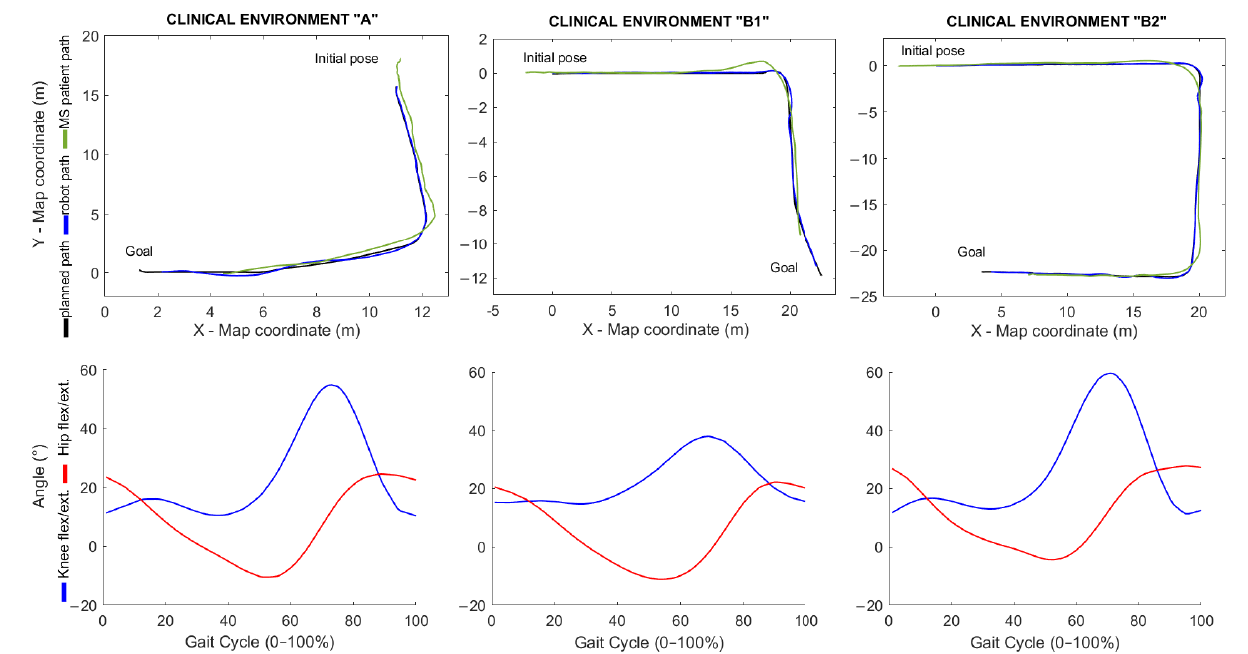
Figure 11. Walking experiments with MS patients in clinical environments. The upper part shows the trajectories, and the lower part shows the kinematic signals of knee and hip flexion/extension.